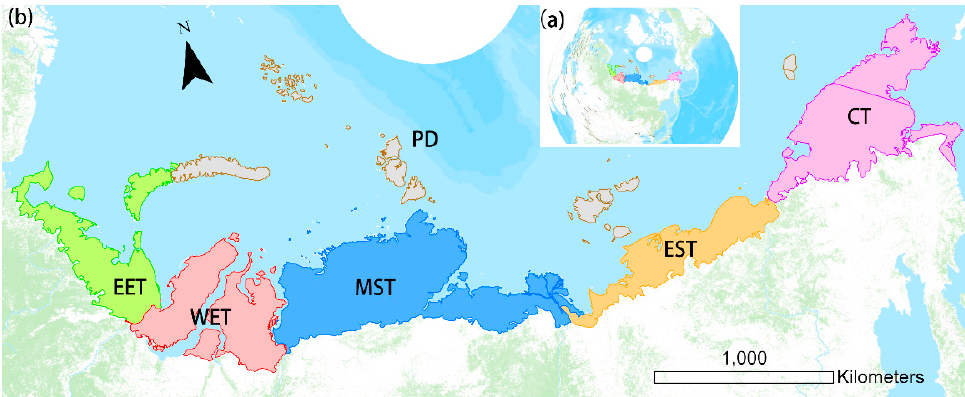
Figure 1. Location of the study area: ( a ) situation of the Russian tundra; ( b ) geographical regions of the tundra zone and the polar desert in Russia. Regions: EET: Eastern European Tundra; WET: Western European Tundra; MST: Middle Siberian Tundra; PD: Polar Desert; EST: Eastern Siberian Tundra; CT: Chukotka Tundra. Table 1. Geographic regions of the tundra zone and the polar desert and their corresponding ecozones in the WWF scheme.